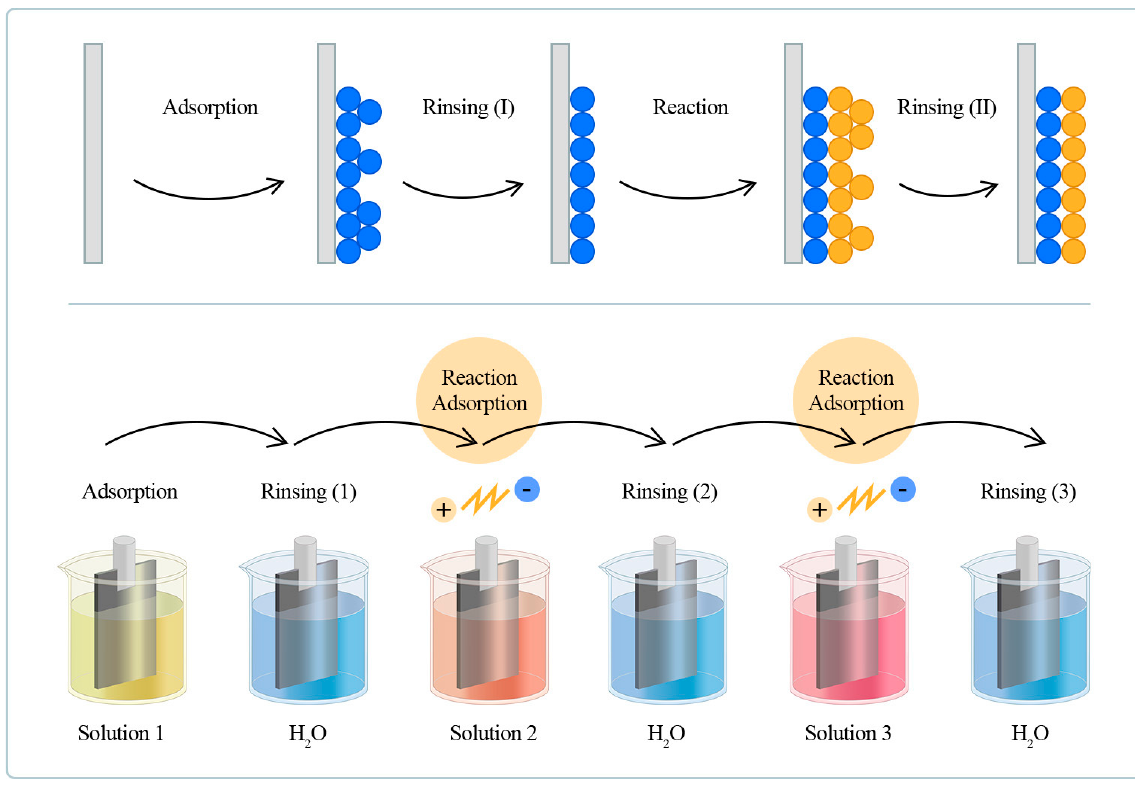
Figure 1. Scheme of the SILAR method for obtaining heterostructure Cd x Te y O z /CdS/ZnO. One cycle of Cd x Te y O z formation consisted of (3–6) stages. Five such cycles were con-